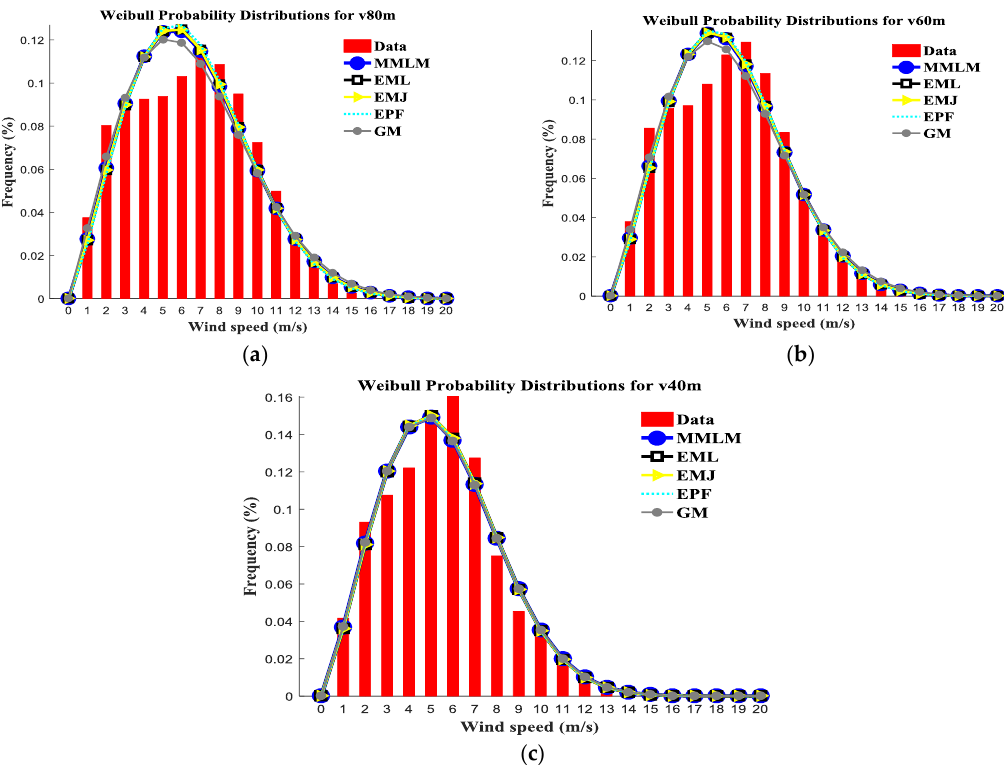
Figure 12. Comparison of placing the five different methods of Weibull probability distributions to measured data for Sanghar site ( a ) at 80 m height ( b ) at 60 m height and ( c ) at 40 m height.